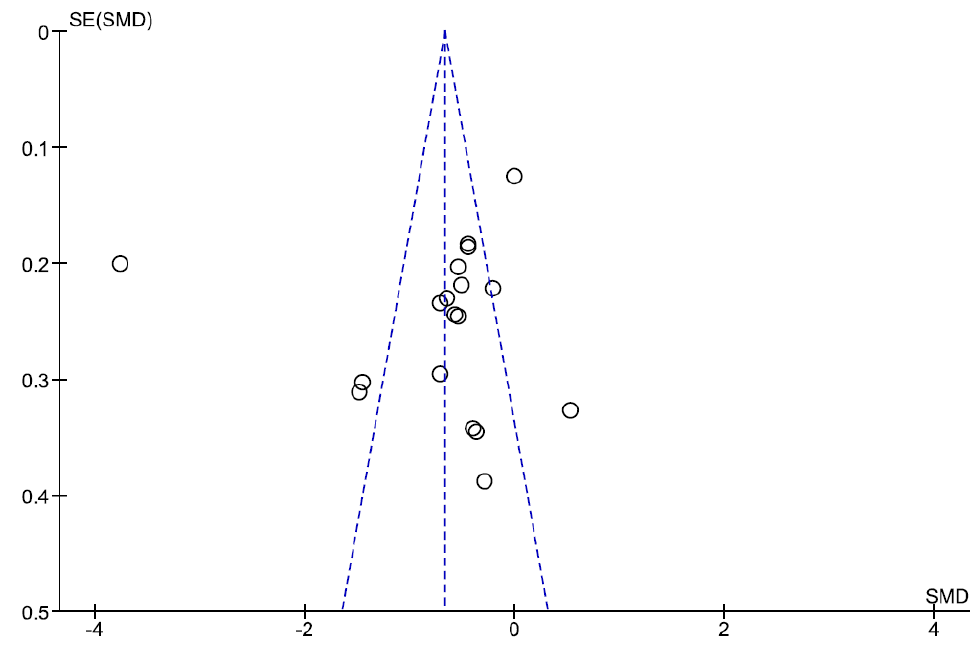
Figure 5. The funnel plot for meta-analysis on the overall interventions that were utilized in reducing internalized stigma in comparison to Treatment as Usual or the Waiting List.